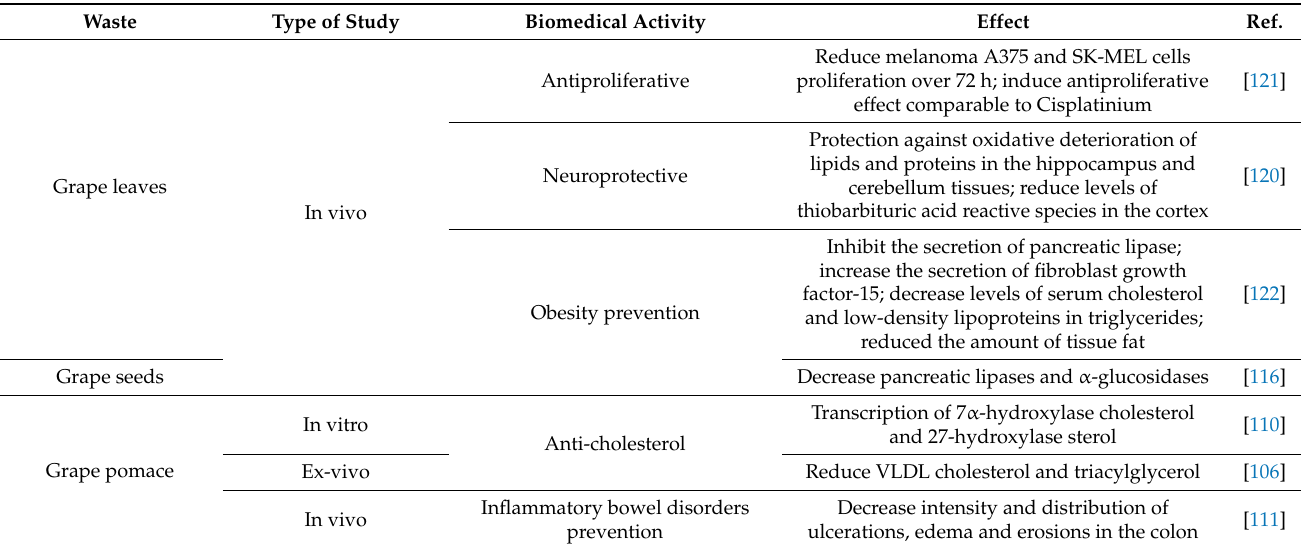
Table 4. Examples of biomedical applications of compounds from grapevine